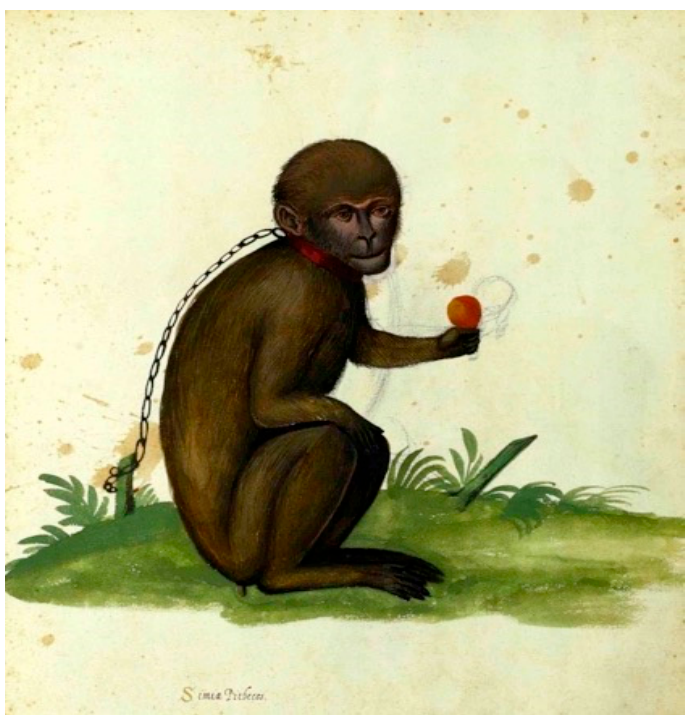
Figure 4. The Aldrovandi’s Simia Pithecos. Tavole Animali, vol. I. 2, p. 109, http://aldrovandi.dfc.unibo.it/ (© Alma Mater Studiorum. Università di Bologna—Biblioteca Universitaria di